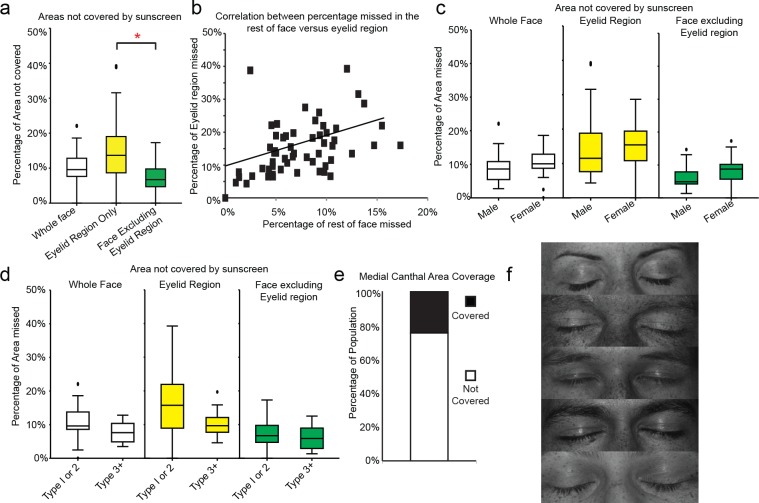
Eyelid regions and medial canthal areas are disproportionately missed during routine sunscreen application.a) Box and whisker plot of percentage of indicated region missed as detected by automated image analysis software. Line represents median, boxes represent 25 to 75th percentile, whiskers 5th and 95th percentile, outliers denoted by black dots, n = 57. * denote significant difference between bracketed groups p<0.01 Mann Whitney test b) Dot plot of percentage area of rest of face missed versus percentage missed in eyelid region. Each dot represents one individual from the trial, n = 57. Spearman correlation coefficient 0.84, p<0.01. c) Box and whisker plots comparing male and females sunscreen application effectiveness plotted as percentage missed of the indicated regions, plotted as in b), d) box and whisker plot comparing application with self-assessed skin type, grouped as types 1 or 2 (n = 42) compared with types 3 or higher (n = 15), plotted as for b), e) Bar chart of percentage of population that either completely covered or failed to cover medial canthal regions. f) Representative UV images of six participants eyelid regions without sunscreen application. Note the dark spots indicating presence of UV damaged skin i.e, areas of pigmentation deep in the dermis that are invisible to the naked eye but visible to UV photography.